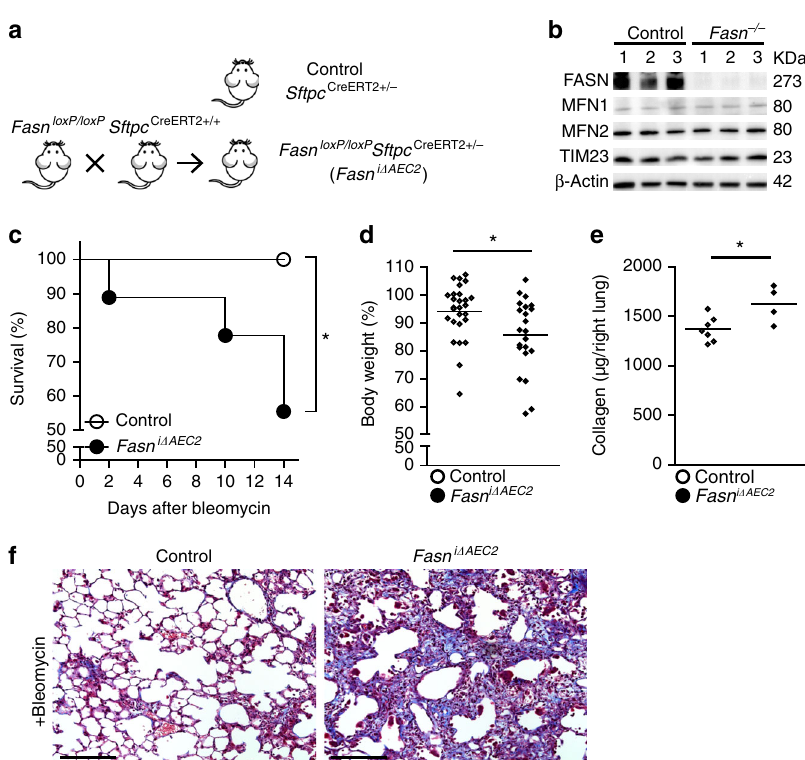
Fig. 8 Impaired fatty acid synthesis in AEC2 cells promotes bleomycin-induced lung fi brosis. a Schema outlining the generation of mice with tamoxifen- inducible Fasn knockout in AEC2 cells. b Immunoblots showing MFN1, MFN2, TIM23 and β -actin expression in AEC2 cells from control or Fasn i Δ AEC2 mice ( n = 3 mice per group). c – e Kaplan – Meier survival curves (control n = 9, Fasn i Δ AEC2 n = 9; * p < 0.05, by log-rank test) ( c ), body weight changes (control n = 27, Fasn i Δ AEC2 n = 22) ( d ) and acid-soluble collagen depositions in right lung (control n = 7, Fasn i Δ AEC2 n = 4) after bleomycin treatment ( e ) ( d , e the line indicates mean; * p < 0.05, by unpaired Student ’ s t test). f Representative Masson ’ s Trichrome-stained lung sections (200X magni fi cation; scale bar 200 μ m) of mice 14 days after bleomycin treatment ( n = 5 mice per group). Source data ( b – e ) are provided as a Source Data fi